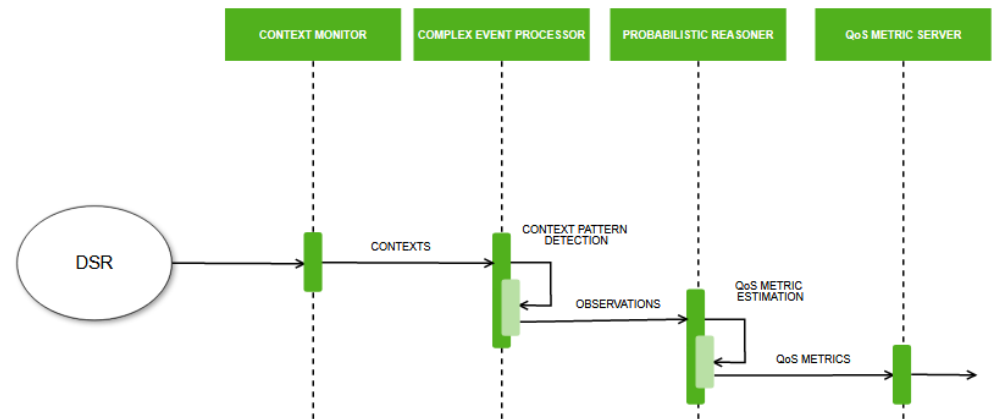
Figure 7. A sequence diagram showing data exchange within modules in the Quality of Service (QoS) Metrics Provider